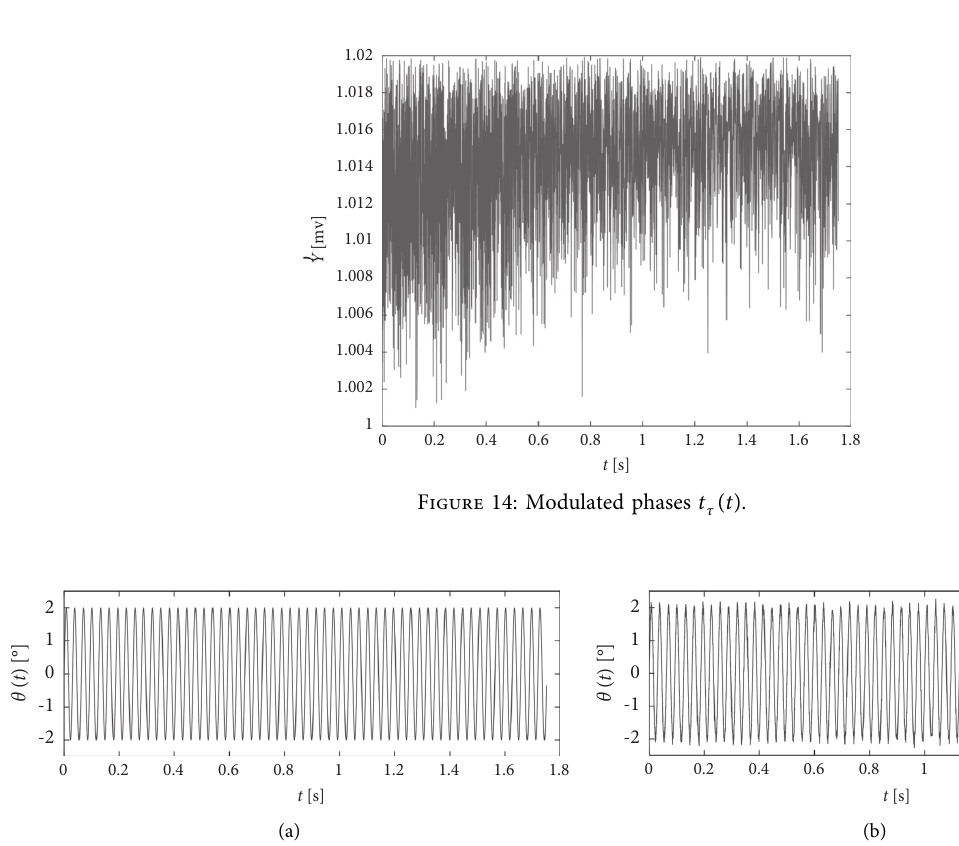
Figure 15: Results of torsional vibration angle: (a) actual and (b) calculated.